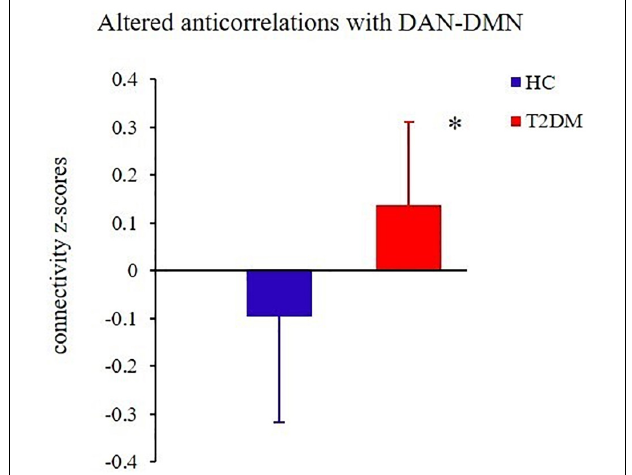
FIGURE 3 | Comparisons of inter-network FC alterations between the RSNs in the T2DM and HC groups. T2DM group exhibited increased FC between the DAN and DMN compared with HC. Color scale denotes the t -value. Warm color represents positive functional connectivity; cold color represents negative functional connectivity.